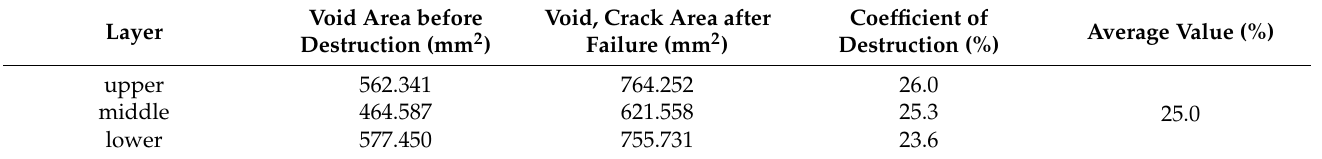
Table 8. Failure coe ffi cient of upper, middle, and lower layers after spli tt ing failure.